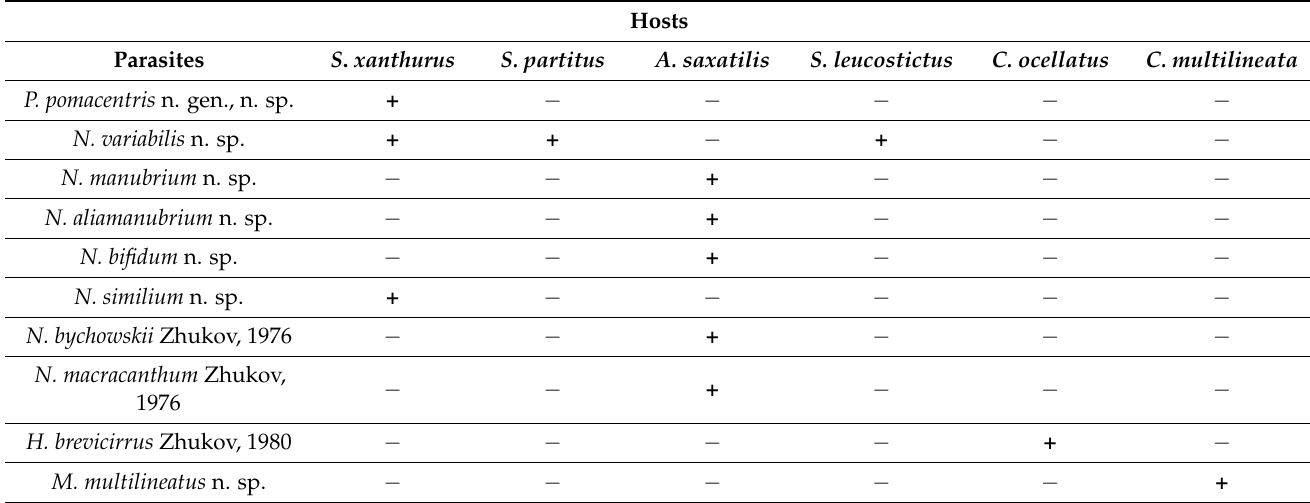
Table 1. Occurrence of monogenoids (Platyhelminthes) parasitizing the gills of pomacentrid and chaetodontid fishes from Cayo Arcas reef, Campeche Bank (Gulf of